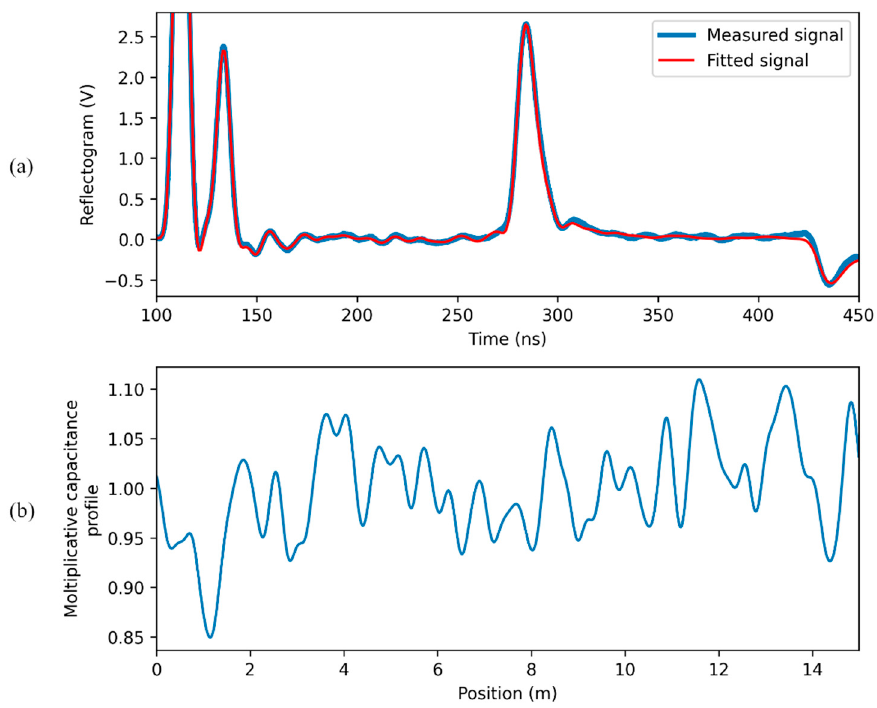
Figure 9. Fitting of the measured signal in the absence of water leaks: ( a ) measured and fitting signal; ( b ) estimated capacitance profile.